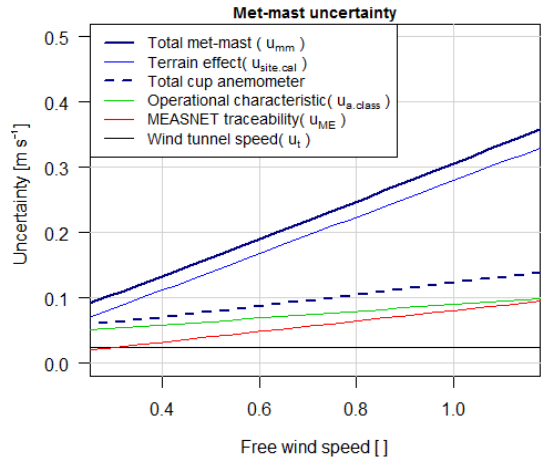
Figure 16. Overview of the size of the various uncertainty compo- nents and total uncertainty.